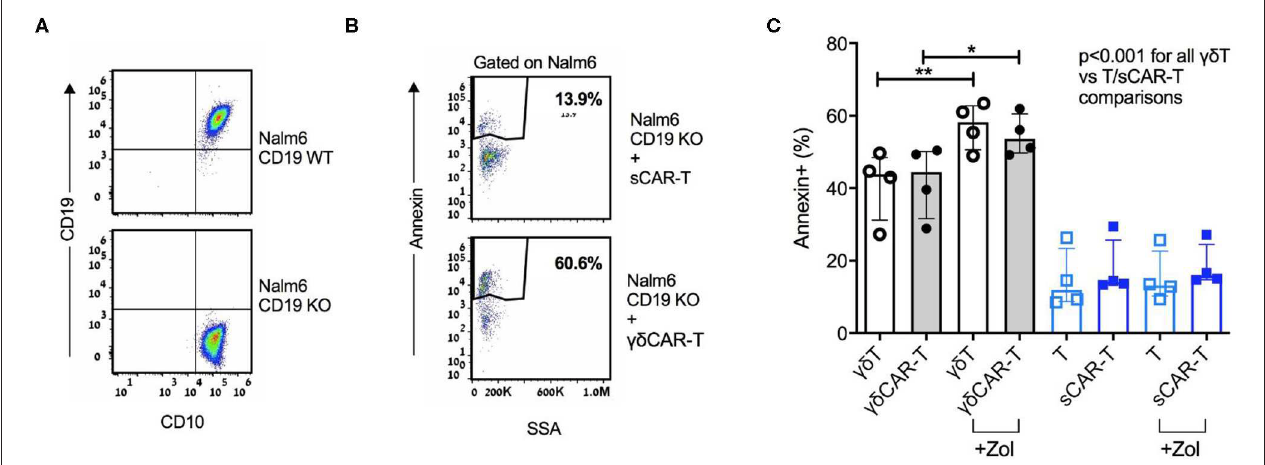
FIGURE 3 | γδ CAR-T cells demonstrate activity against CD19 negative clones. (A) Generation of Nalm6 CD19 KO cells via CRISPR yields CD10 positive CD19 negative cells (Nalm6 19neg ). (B,C) Activity of γδ CAR-T cells against Nalm6 19neg cells is further enhanced by priming the target cells with zoledronate. (B) Dot plot representation showing Annexin staining of targets cells (cell-trace violet stained Nalm6 19neg ) co-cultured with sCAR-T cells (top) or γδ CAR-T cells (bottom). (C) Specific cytotoxicity of different effectors against Nalm6 19neg cells. γδ -T and γδ CAR-T cells in gray bars, sT, and sCAR-T cells in blue bars. Un-transduced cells in unstained circles and CAR-T cells in filled circles. * P ≤ 0.05, ** P ≤ 0.01, Two tailed paired T -test. Error bars represent interquartile